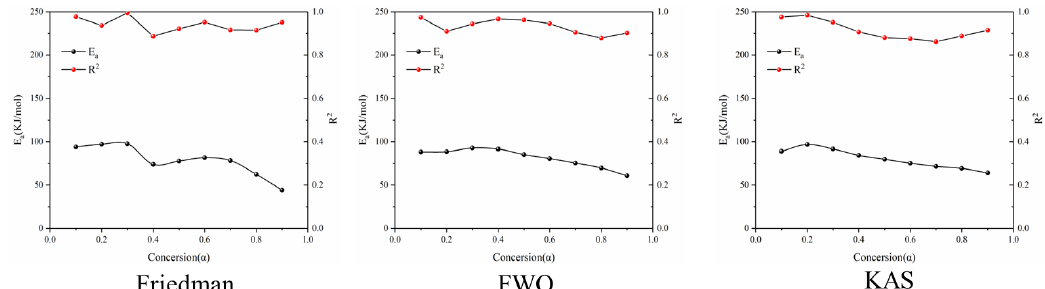
Figure 4. Conversion curve of the first stage of battery material pyrolysis.